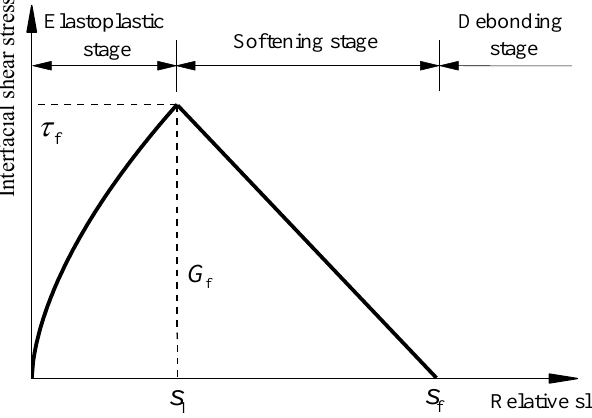
Figure 7. Bond – slip model for CFRP plate and corroded steel